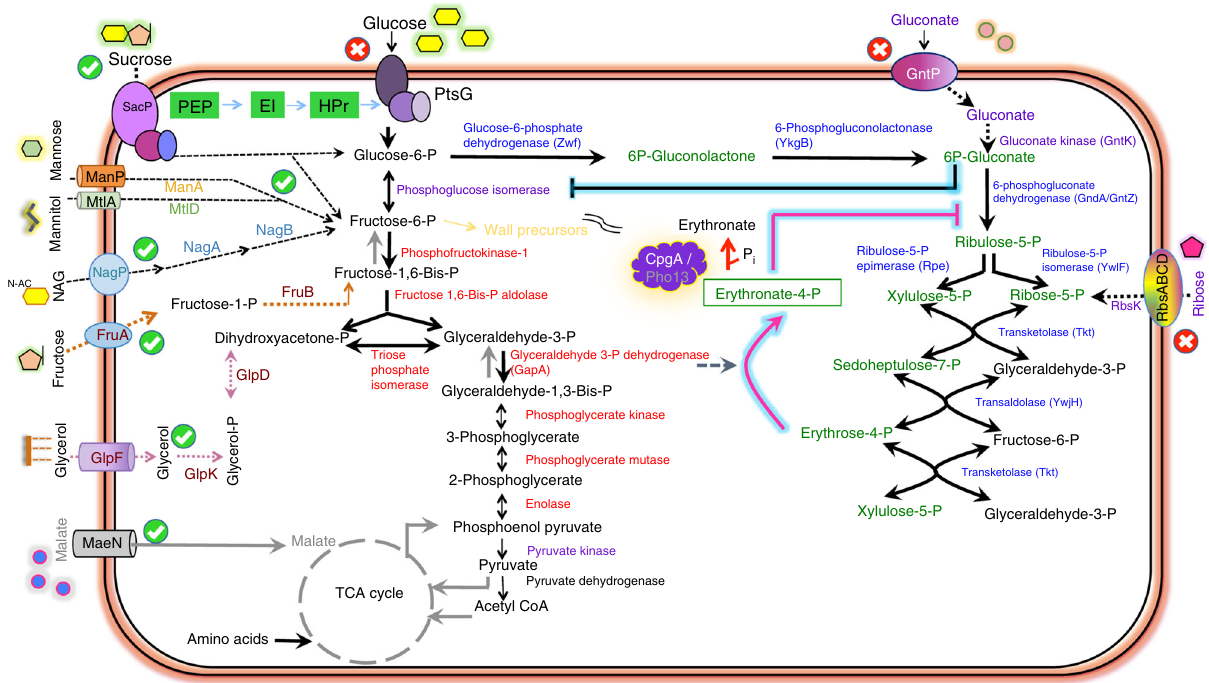
Fig. 1 CpgA is pivotal in prevention of 4PE-mediated metabolic gridlock. PtsG functions as a glucose PTS importer (EII Glc class) working with HPr (Histidine protein), EI (Enzyme I), and PEP (phosphoenolpyruvate) to import glucose (yellow hexagons). Other enzymes and proteins mentioned in the text are shown. Metabolites of glycolysis are depicted in black (enzymes in red), and pentose phosphate pathway intermediates are depicted in green (enzymes in blue). Highlighted arrows illustrate the accidental metabolite 4PE arising from the promiscuous reaction of GapA with erythrose-4-phosphate to generate 4-P-erythronate (4PE), which inhibits GndA/GntZ. CpgA or yeast Pho13 (depicted as purple protein) convert 4PE to erythronate. Inhibition of GndA/GntZ causes accumulation of 6-phosphogluconate which further blocks phosphoglucose isomerase (PGI) leading to a metabolic gridlock in core pathways. A green circle with check mark indicates carbon sources that support growth of the cpgA null mutant, and those carbon sources that lead to intoxication are shown as red circles with cross